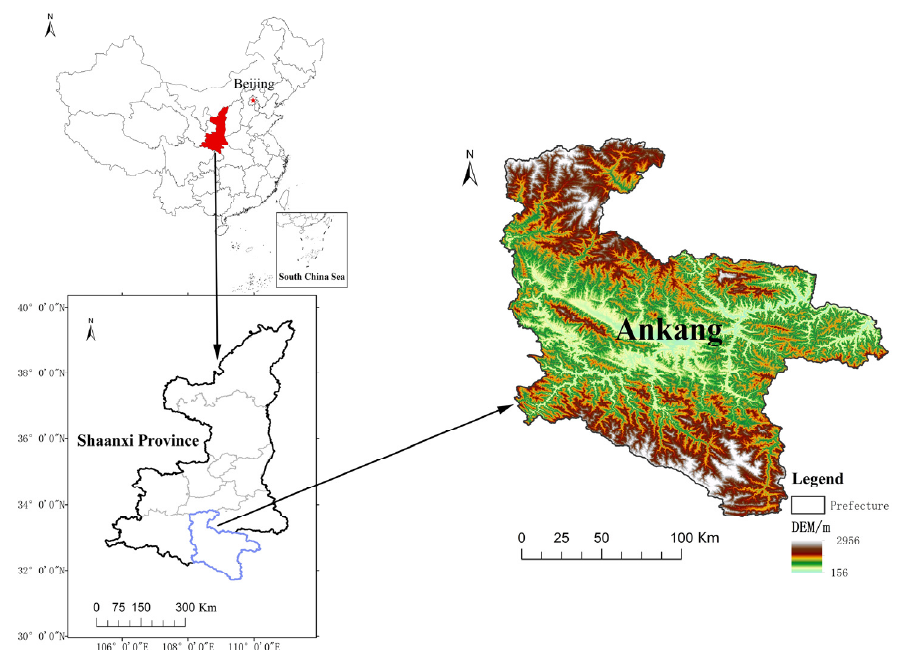
Figure 1. Location of the study area.